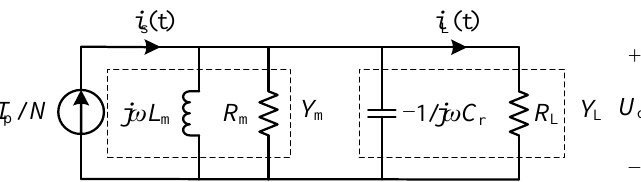
Figure 5. CT energy harvesting circuit with compensation capacitance.